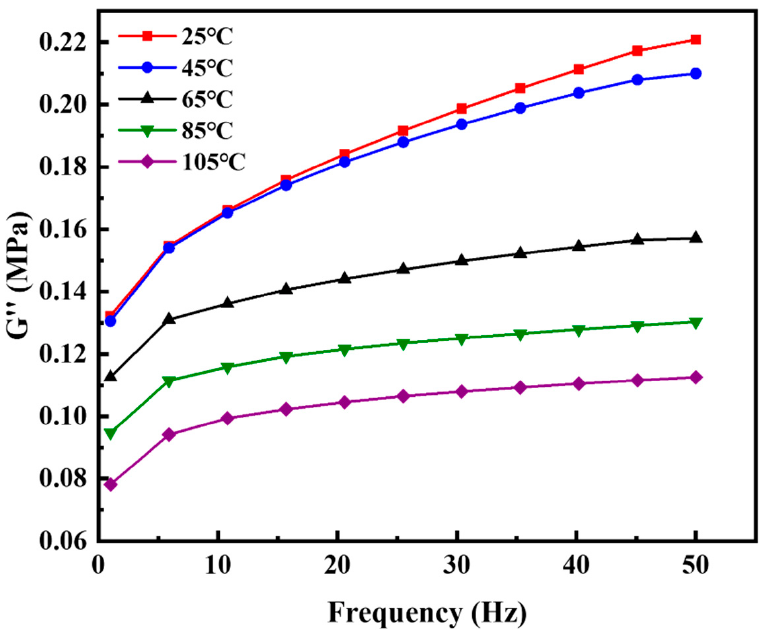
Figure 9. The dependence of loss modulus on frequency at different temperatures. The frequency sweeps from 1 Hz to 50 Hz. Temperature scans from 25 °C to 105 °C in 20 °C intervals.